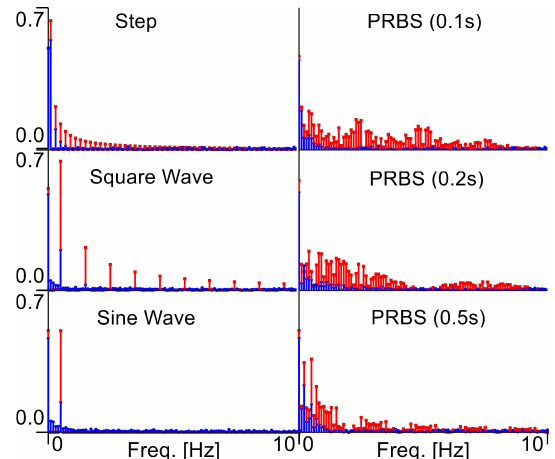
Figure 16: The Fast Fourier Transform (FFT) can be used to obtain a frequency domain repres- entation of the dynamic information content in both input and simulated output. Input u (red) and output, including measurement noise, y (blue) is